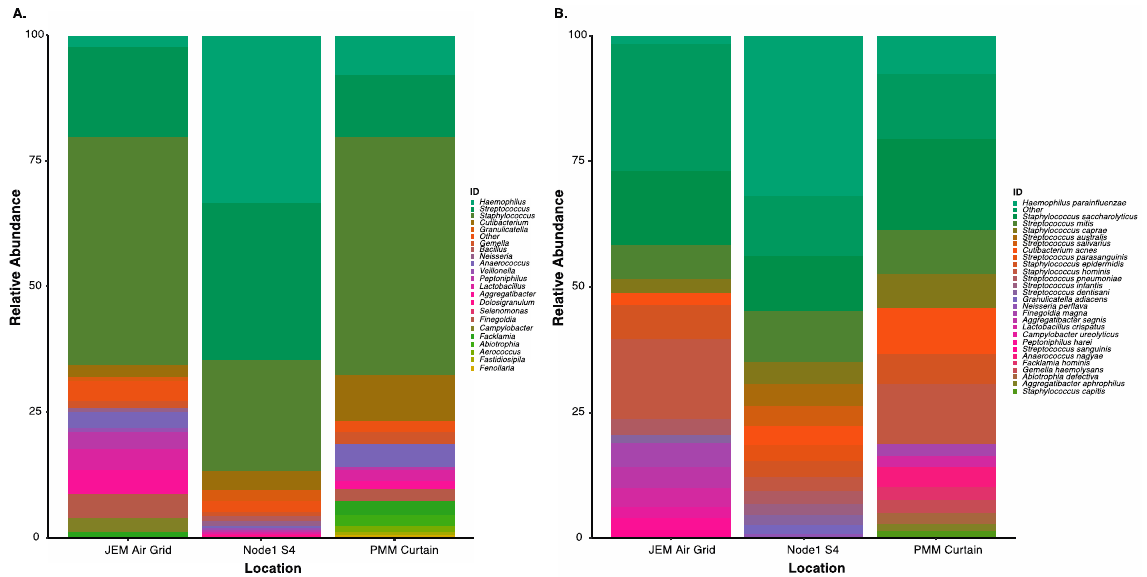
Figure 5. Microbial profile of the top 15 ( A ). genus and ( B ). suggested species level identifications present at three distinct locations onboard the International Space Station detected by a culture-independent swab-to-sequencer method. Alignments performed using minimap2 (-ax map-ont).